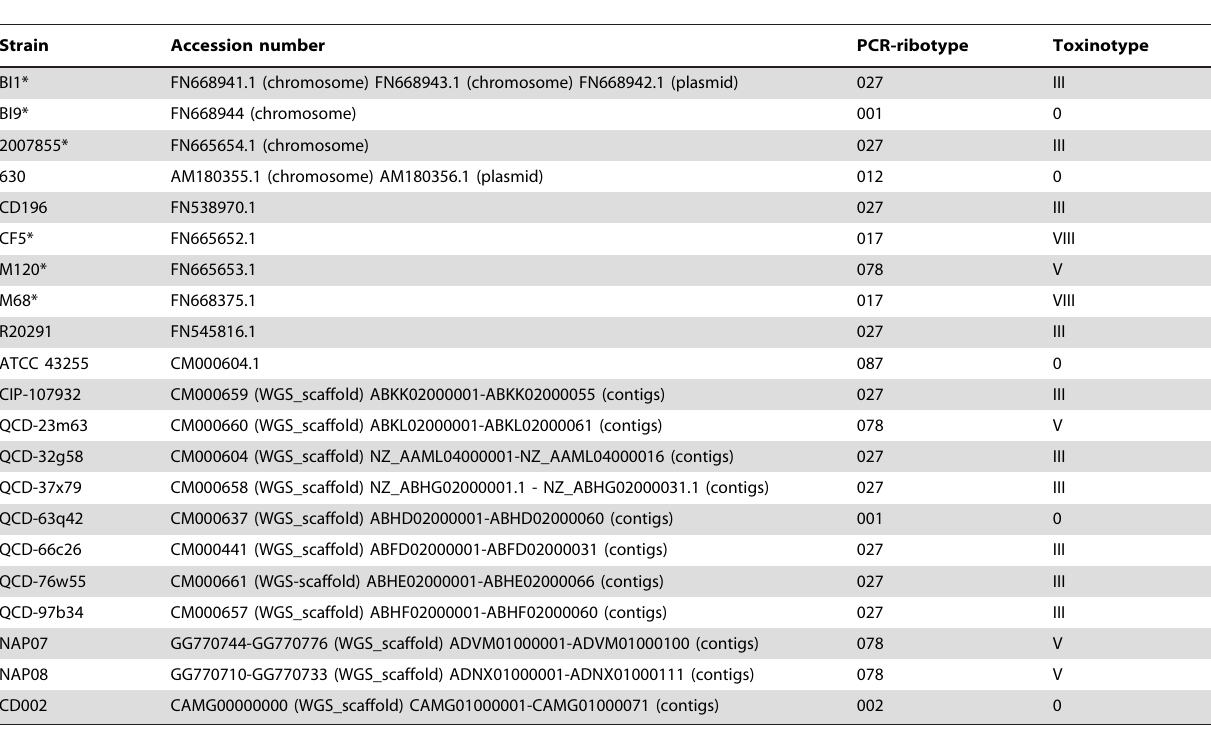
Table 2. Ribotype, toxinotype and accession number of 21 C. difficile strains with previously reported genome sequences used in this